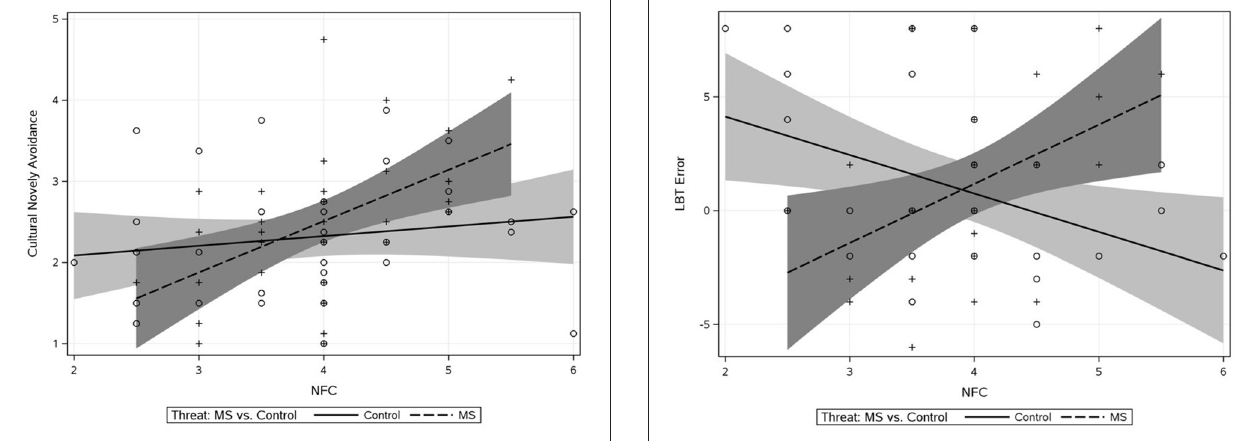
FIGURE 1 | Study 1 effect of threat × NFC interaction on cultural novelty avoidance. Shaded regions represent 95% confidence bands on the regression lines.